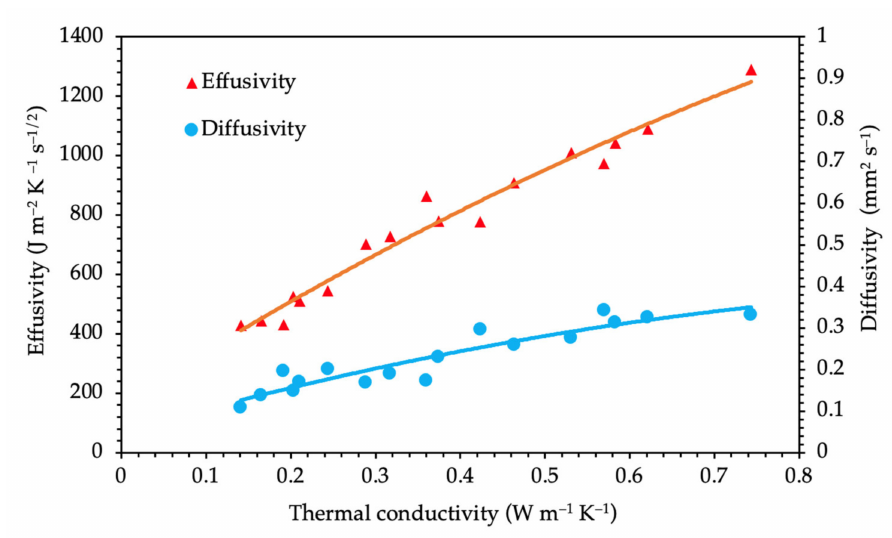
Figure 13. Thermal effusivity and diffusivity versus thermal